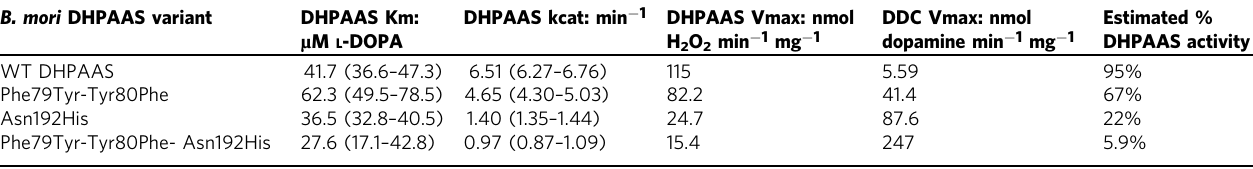
Table 1 DHPAAS and DDC parameters of enzyme variants included in this